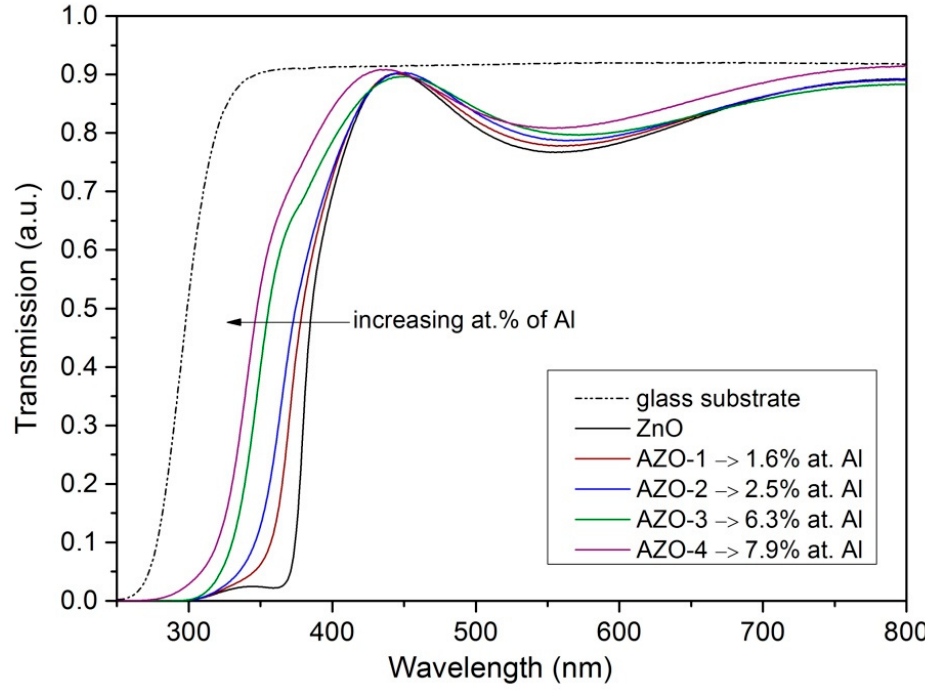
11 of 18 Figure 7. Spectral dependence of refractive index for samples with different contents of aluminum, from ellipsometric measurements (SE) using the general oscillator (GO) model. The transmission spectra of ZnO and AZO1–4 films were also measured by use of a